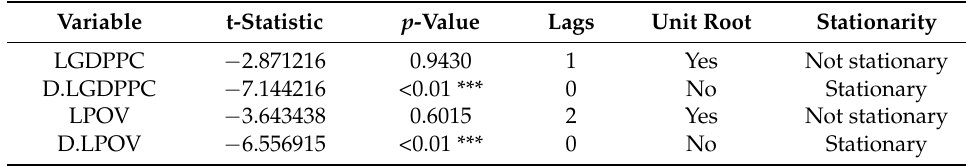
Table 1. Banerjee, Lumsdaine, and Stock Breakpoint Unit Root Test.